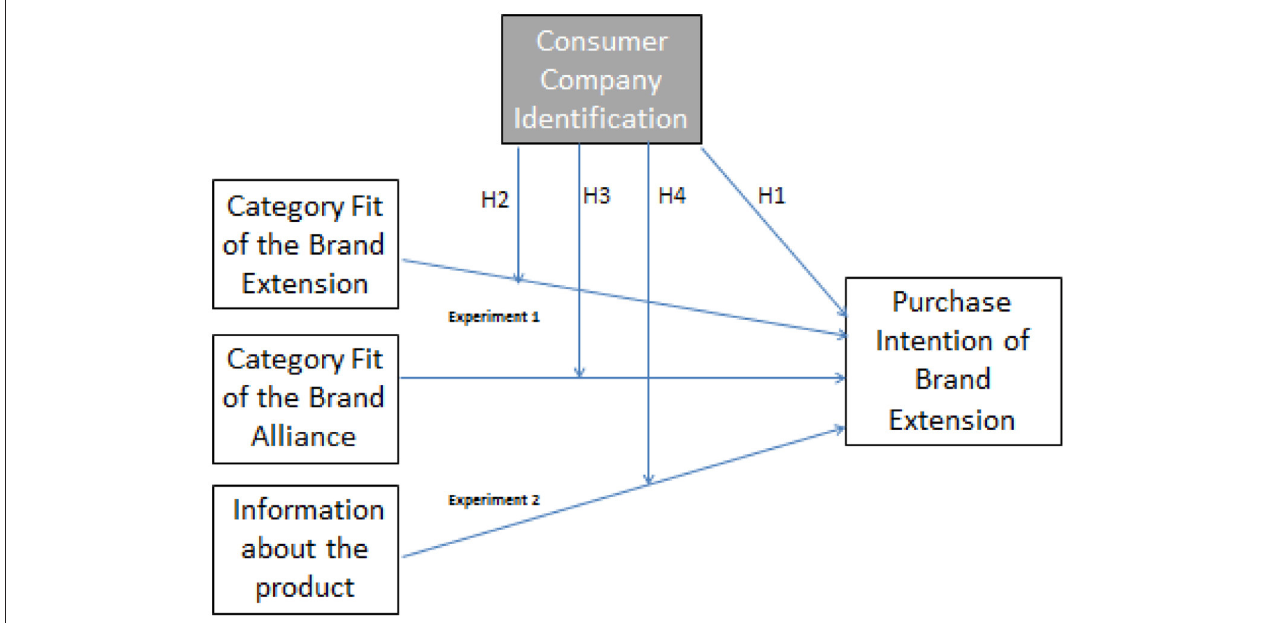
FIGURE 1 | Framework